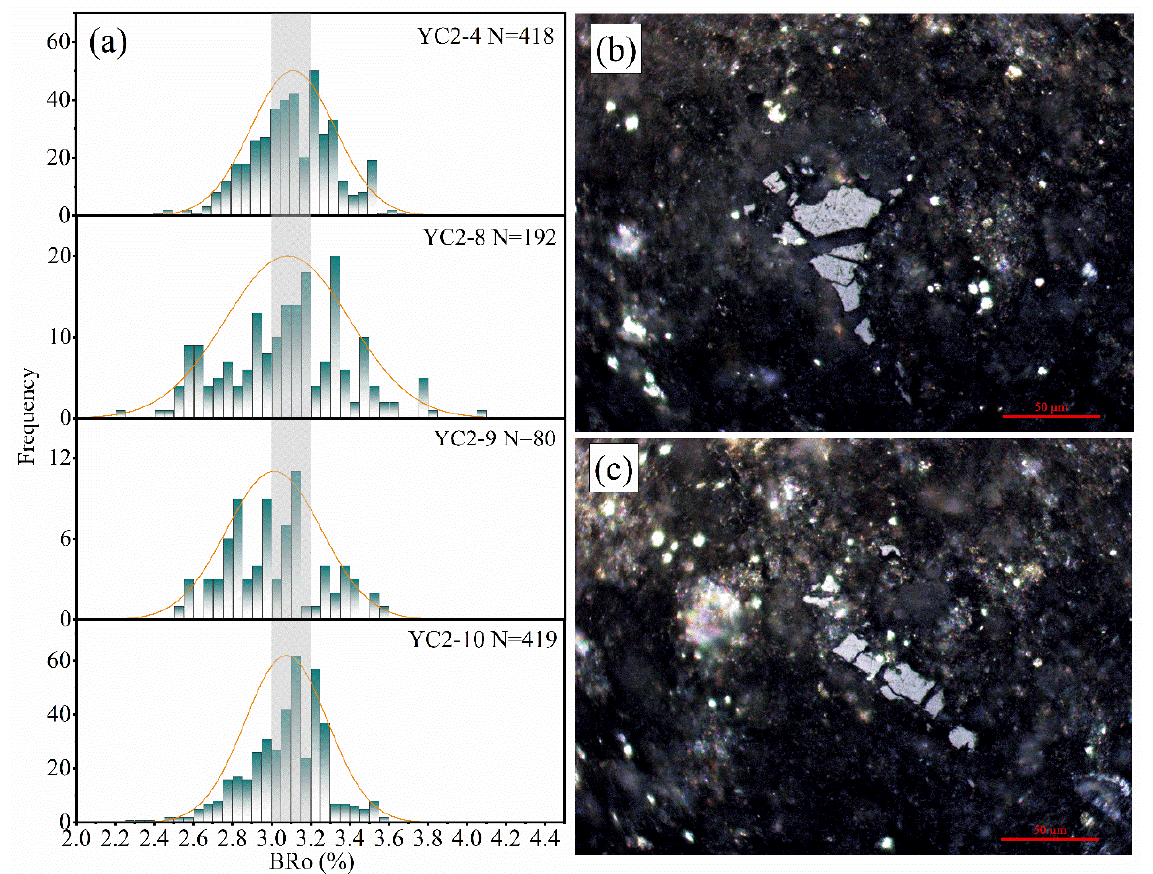
Figure 4. Reflectance distributions of solid bitumen ( a ) and bitumen micrograph ( b , c ) of the selected shale samples from well YC2.